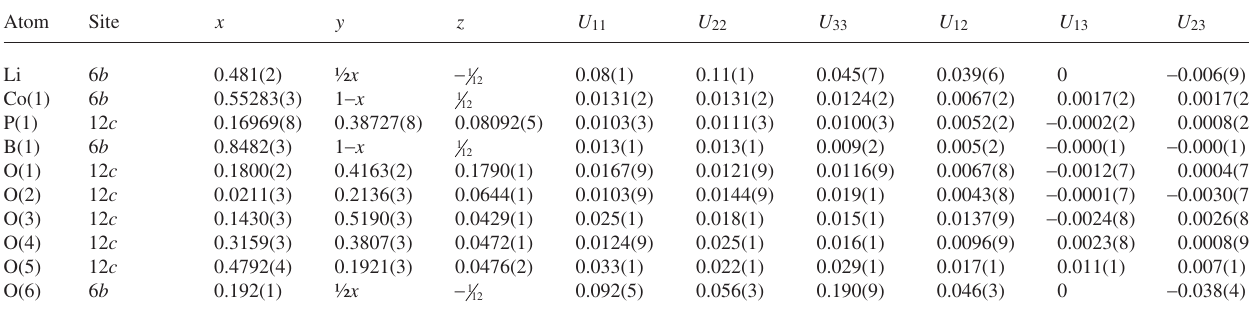
Table 3. Atomic coordinates and displacement parameters (in Å 2 )